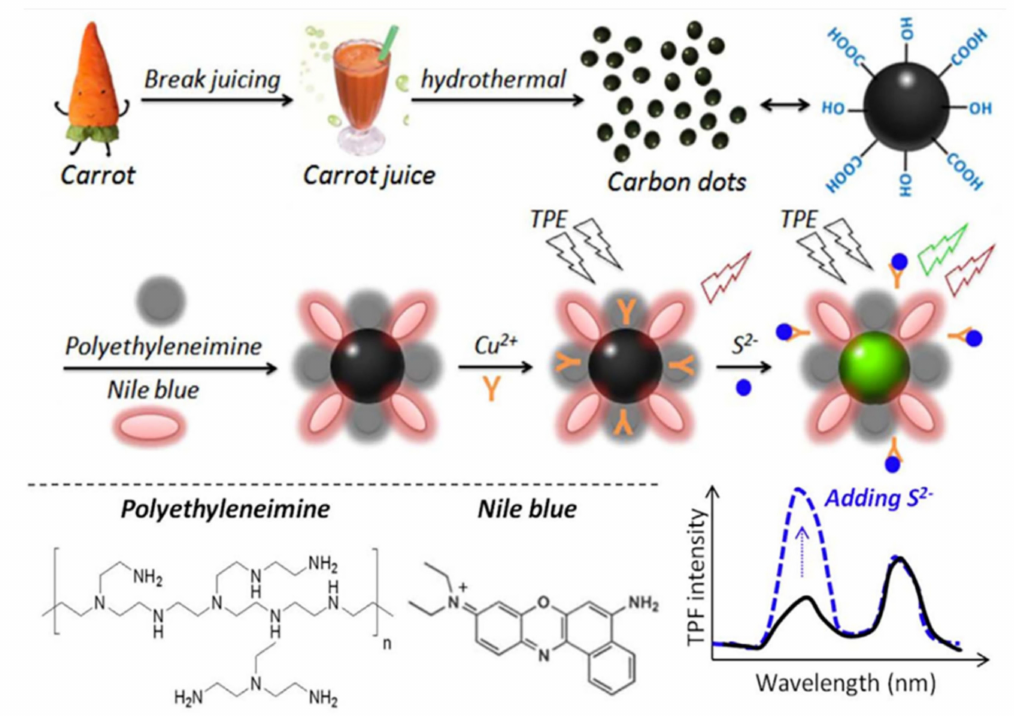
Figure 7. Schematic illustration of the preparation of CDs and CDs/PEI/NB nanocomposites for ratio-metric TPF turn-on sensing of S 2 − ions